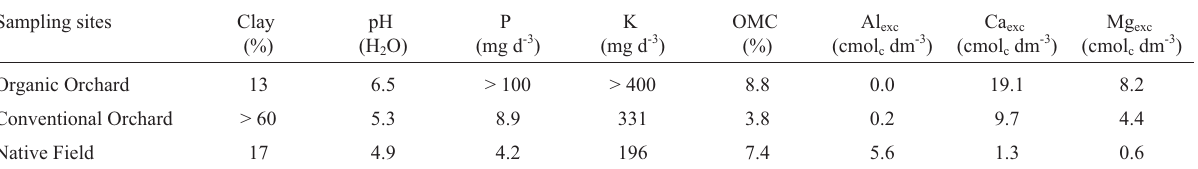
Table 1 - Abiotic soil characteristics of the sampling